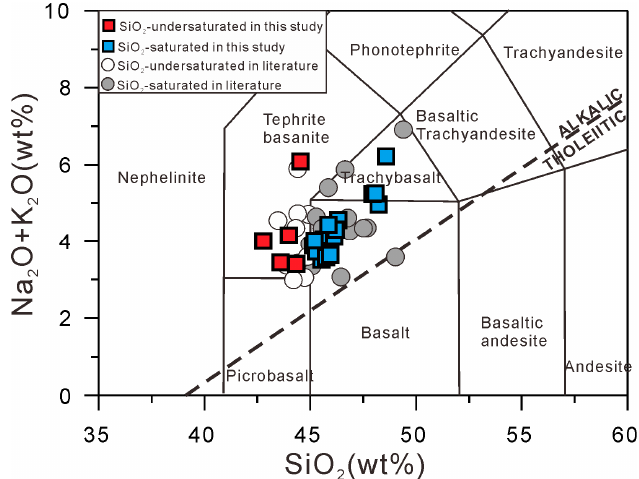
Figure 3. (Na 2 O + K 2 O)–SiO 2 plot of lavas from Pohnpei Island. Major-element data for lavas from previous studies [9,10,18] are included for comparison.